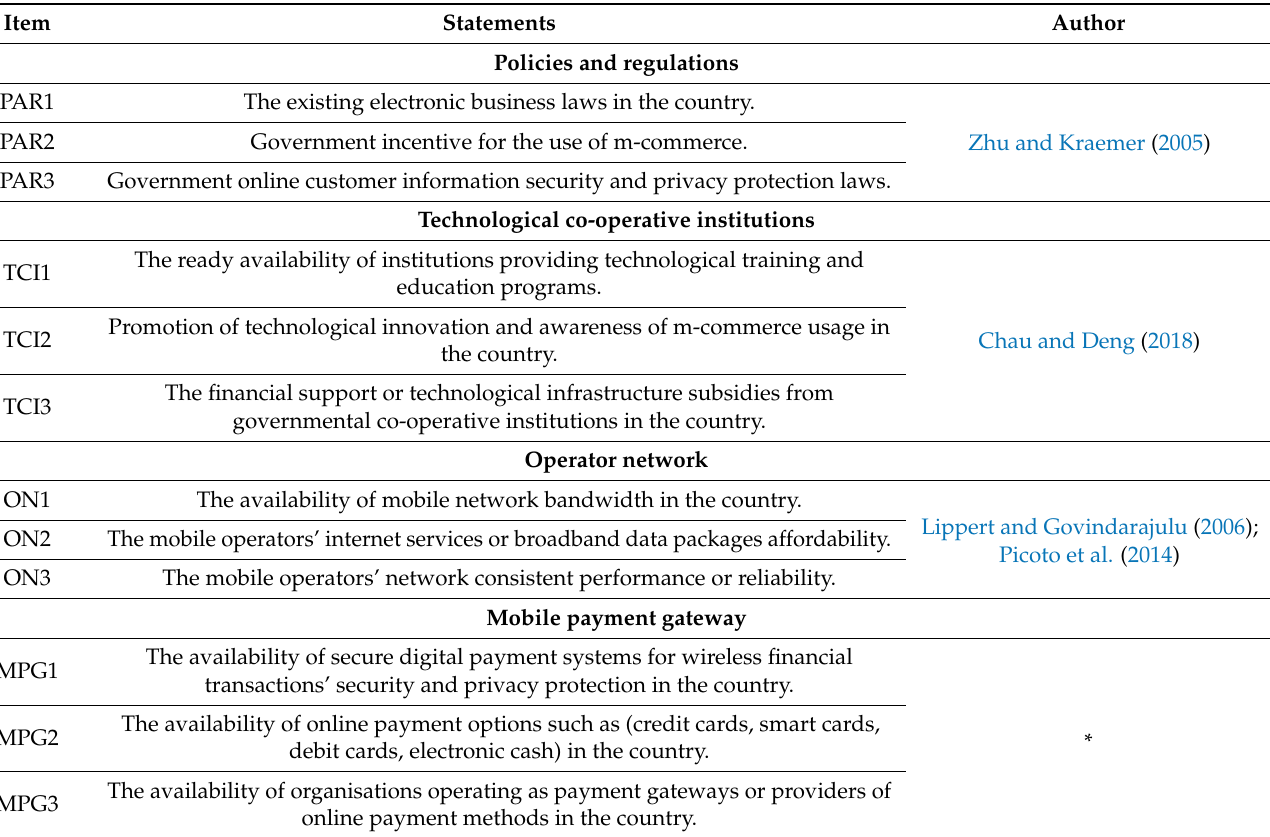
Table A3. Environmental